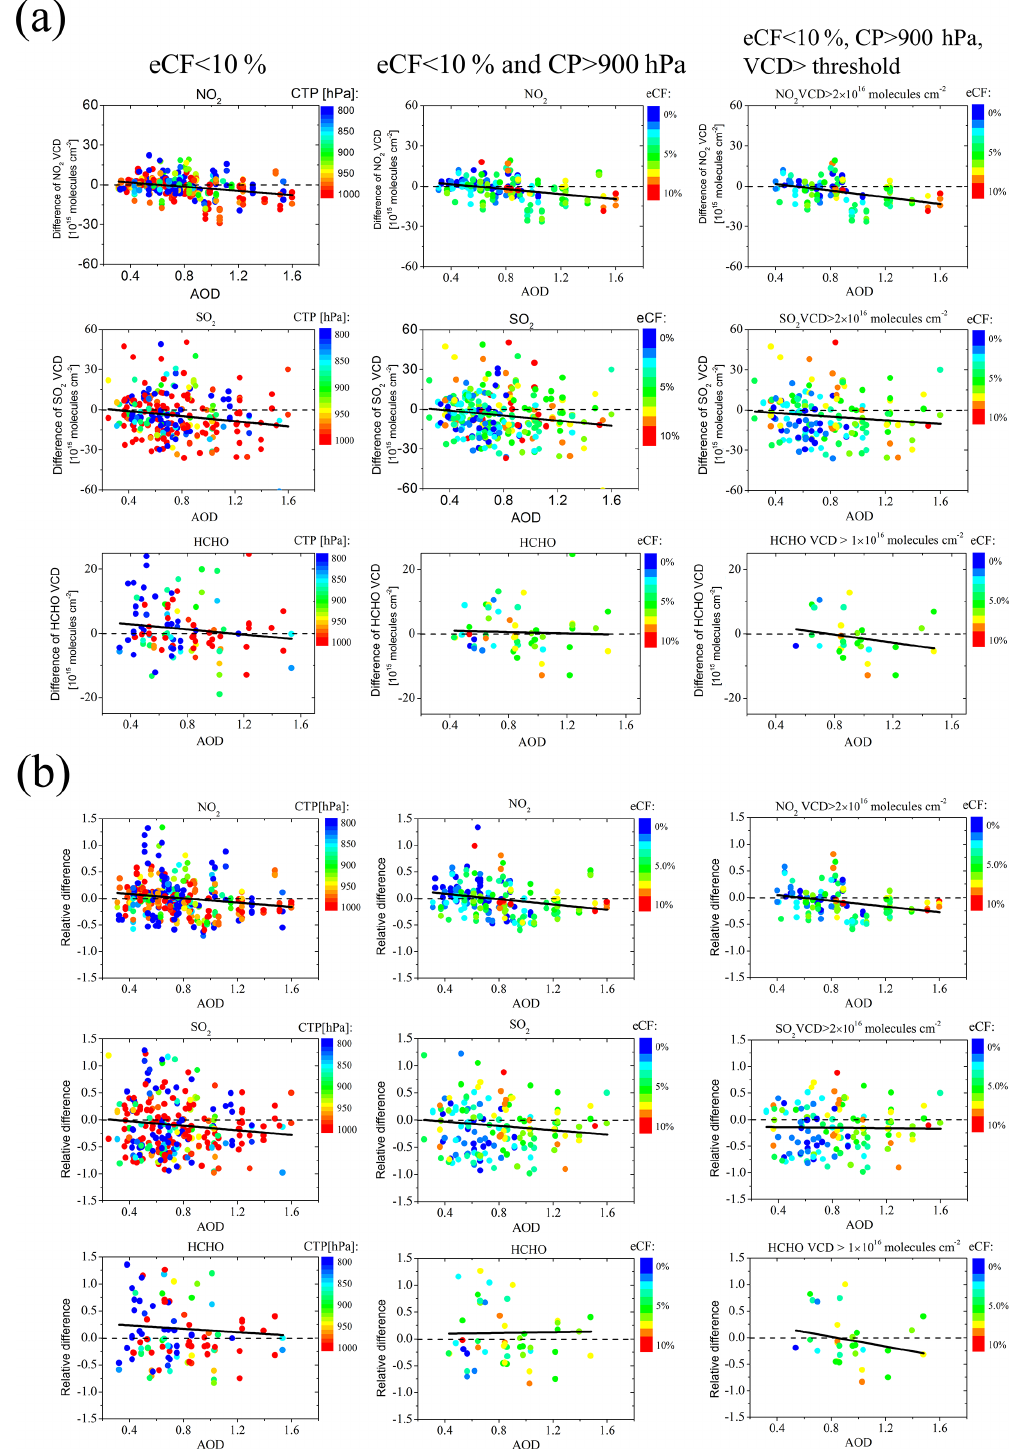
Figure 14. Absolute differences (a) and relative differences (b) of tropospheric VCDs of NO 2 , SO 2 and HCHO between individual OMI observations and MAX-DOAS observations plotted against the AODs derived from the MAX-DOAS observations. The data are differ- ently screened in the left, centre and right panels: eCF<10% for the left; eCF< 10% and CTP>900hPa for the centre; and eCF<10%, CTP>900hPa, and VCD> a specific threshold for the right (see text). Note that the OMI VCDs are the modified values using SFs derived from MAX-DOAS